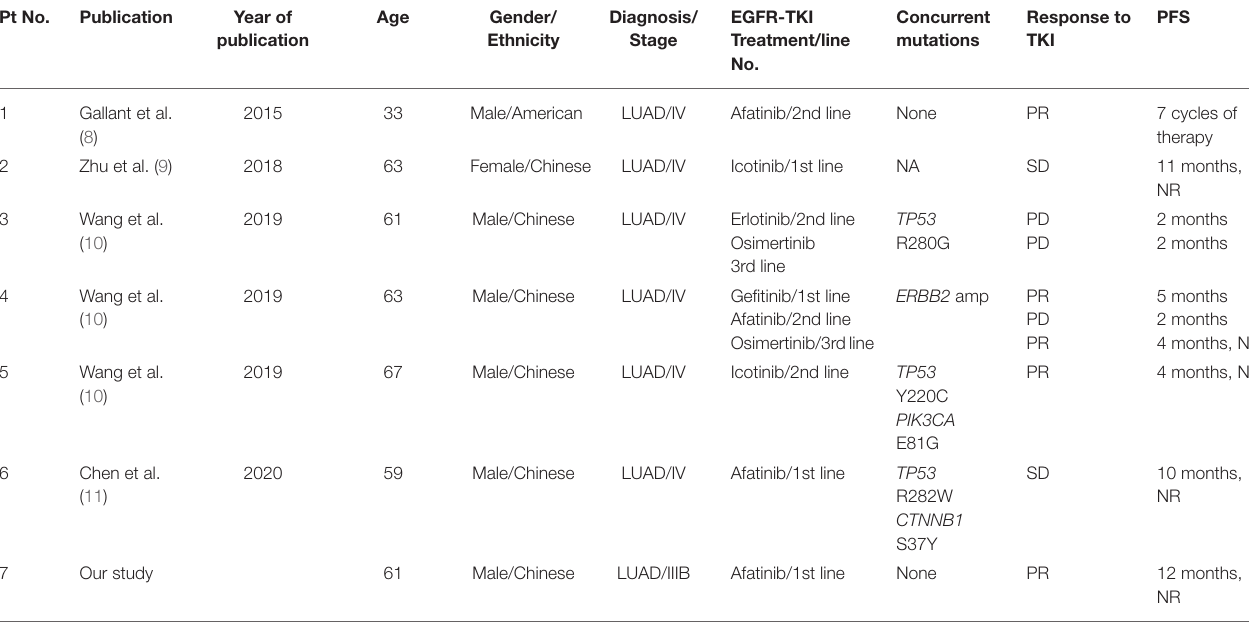
TABLE 1 | Clinical characteristics and outcomes of patients with NSCLC harboring EGFR -KDD in our and previous studies. Pt